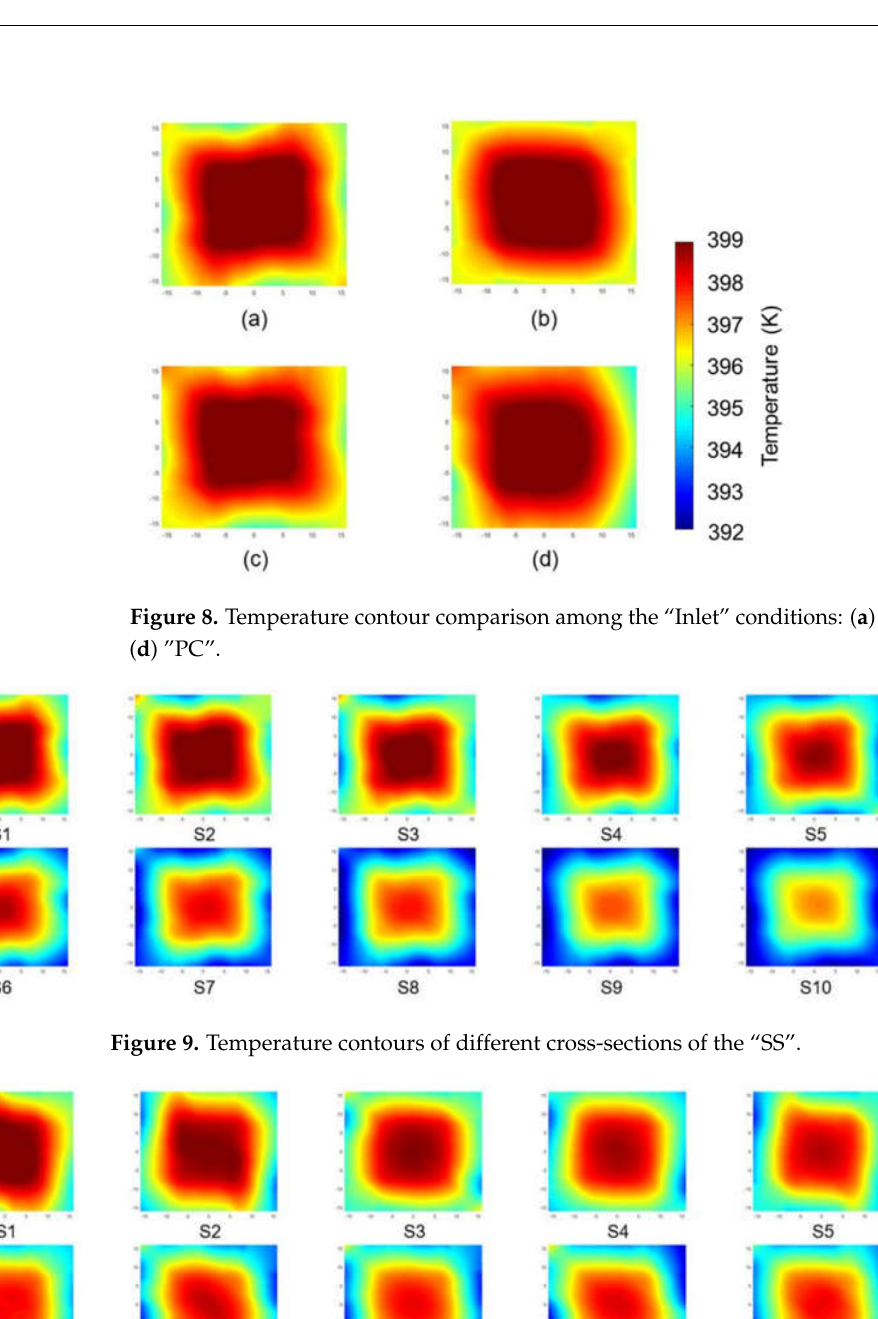
Figure 11. Temperature contours of different cross-sections of the “SC”.